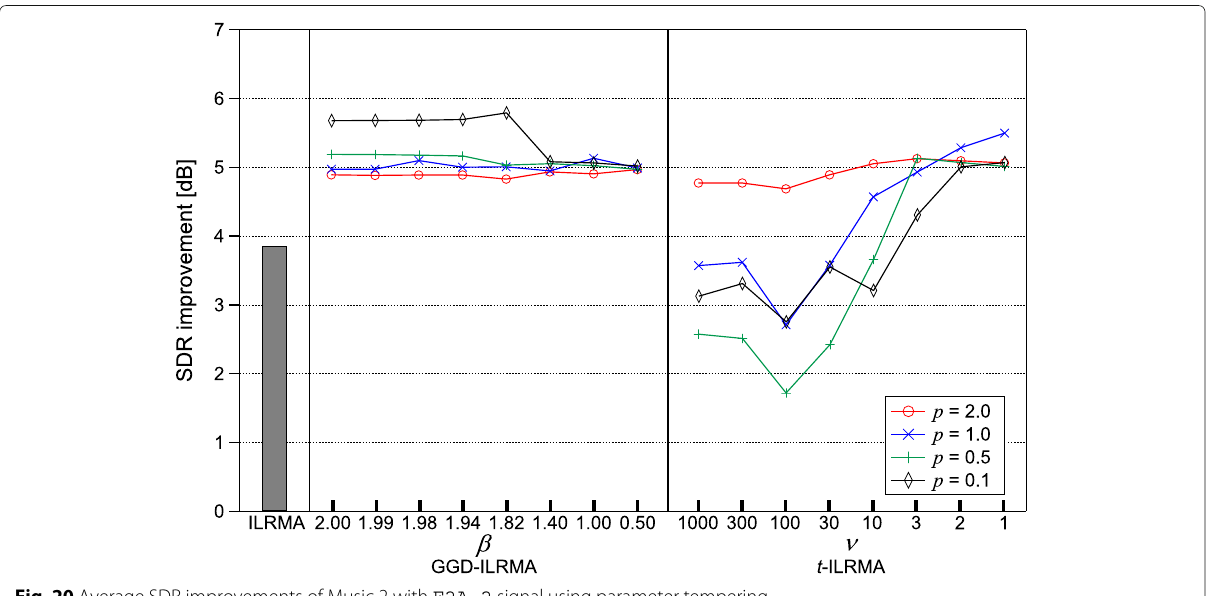
Fig. 20 Average SDR improvements of Music 2 with E2A_2 signal using parameter tempering